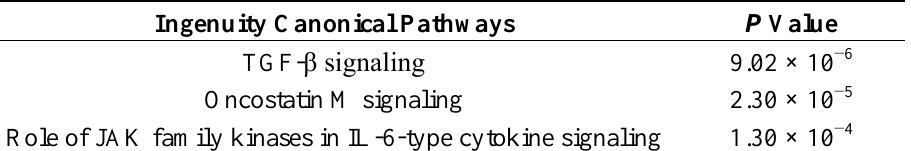
Table 4. Canonical pathways associated with target